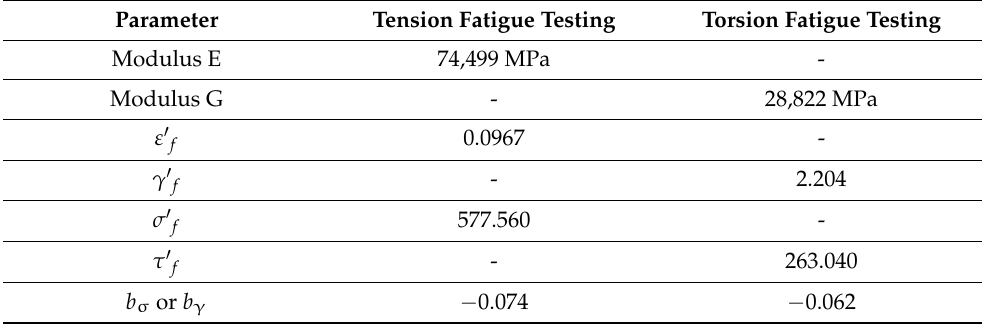
Table 3. Dynamic characteristics of AlMgSi 1.